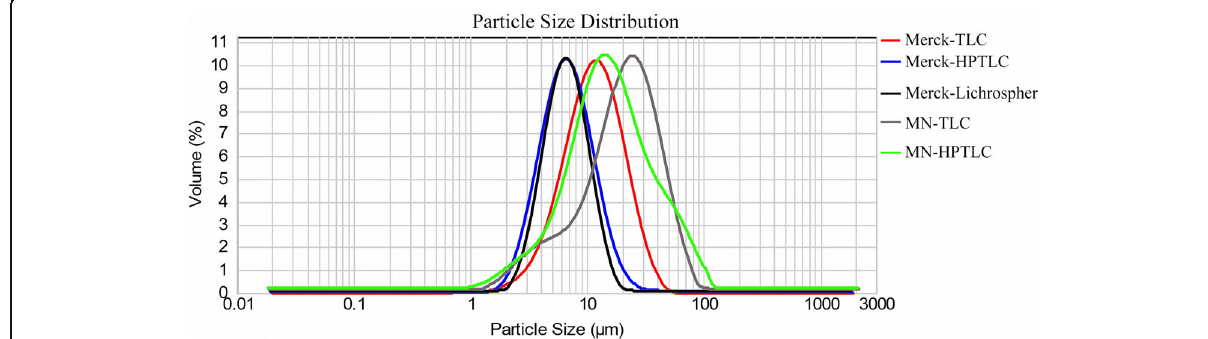
Fig. 2 Concurrent representation of particle size distributions of scraped silica